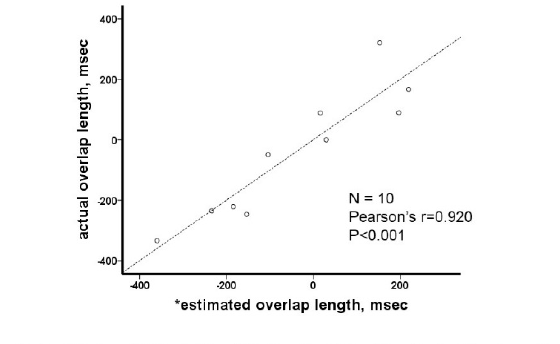
Figure 2. Agreement of the estimated overlap length and the actually measured overlap length. HR; heart rate.